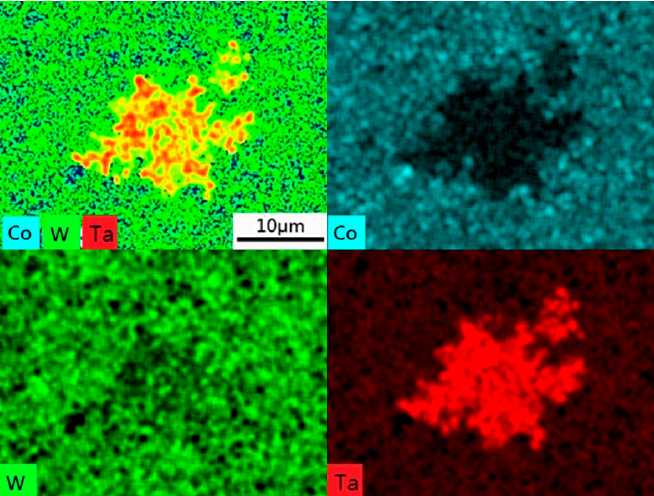
Figure 6. EDS elemental mapping of sample A3 with 0.8 wt. % VC.